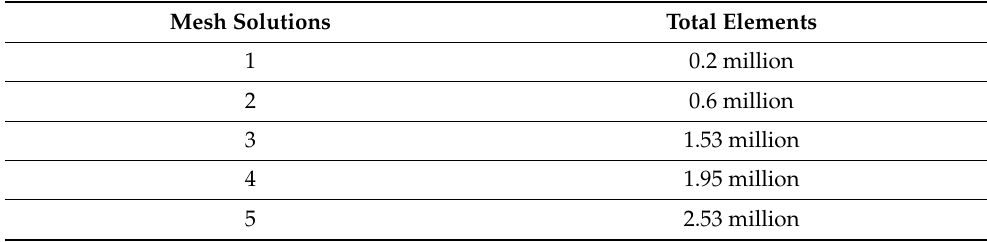
Table 1. Different grid schemes.